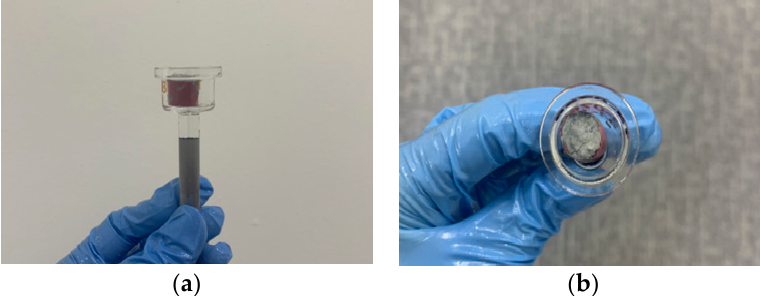
Figure 3. Schematic of cementitious composites for porosity. ( a ) Side view and front view, and ( b ) plan view.